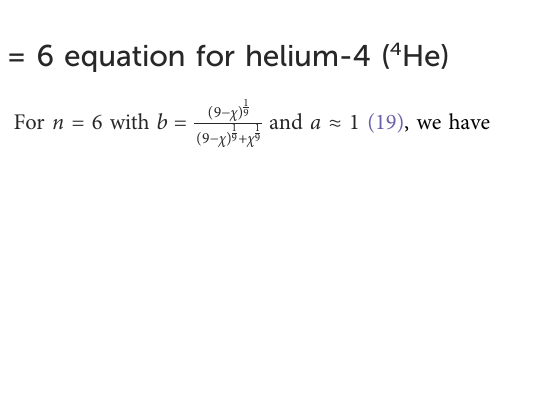
of which the coef fi cients are listed in Table 1.